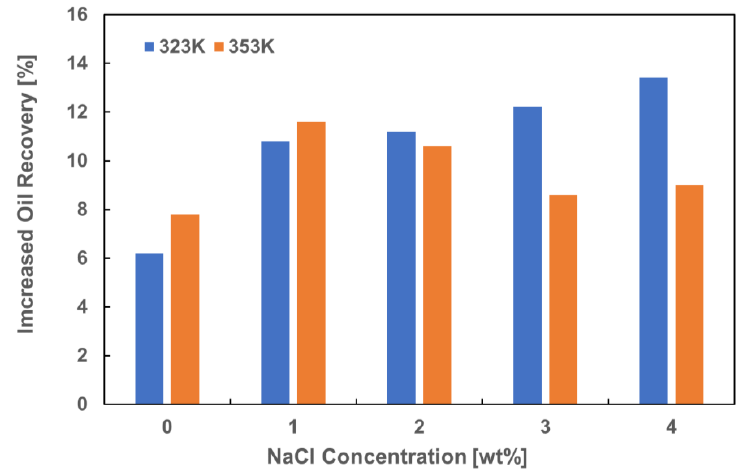
Figure 11. Oil recovery of core flooding experiments in sand-packs with CO2 LSWAG injection at test temperature of 323K and 353K (adapted from Chaturvedi et al. [8]).